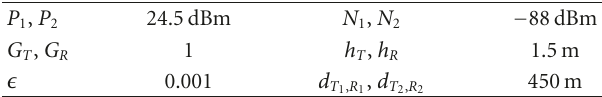
Table 3: Parameters used for the analytical